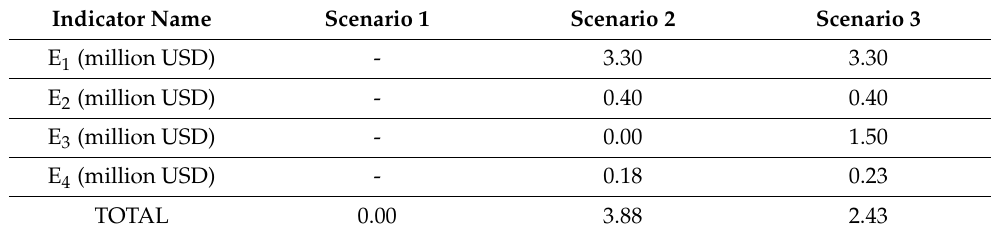
Table 5. Comparison between economic degasification indicator and methane